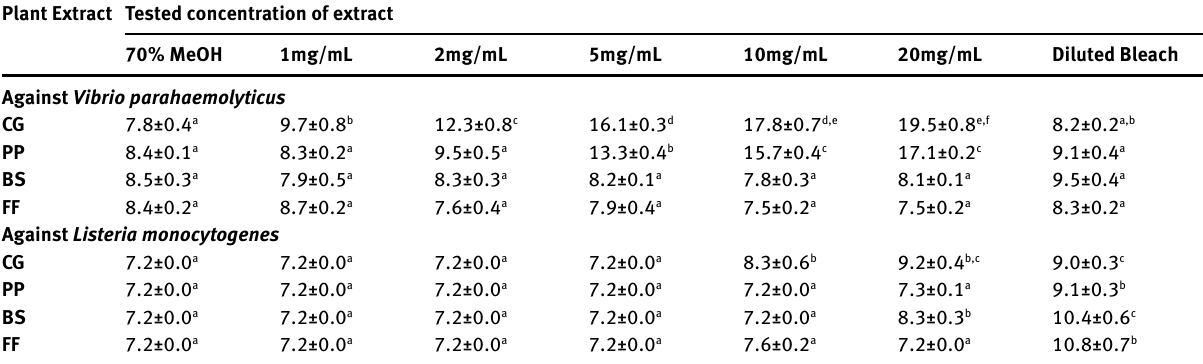
Table 1: Diameters of inhibitory zones (mm) formed by plant extracts against V. parahaemolyticus on salted tryptic soy agar (TSA + 1.5% NaCl), and L. monocytogenes on TSA Plant Extract Tested concentration of